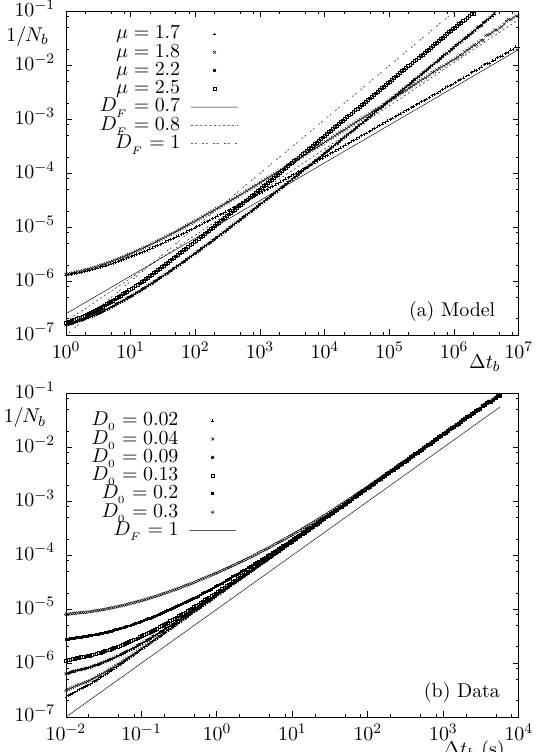
Fig. 3. Computation of the fractal dimension D counting method. (a) Renewal model given by Eqs. (11)–(12), T 1; (b) turbulence